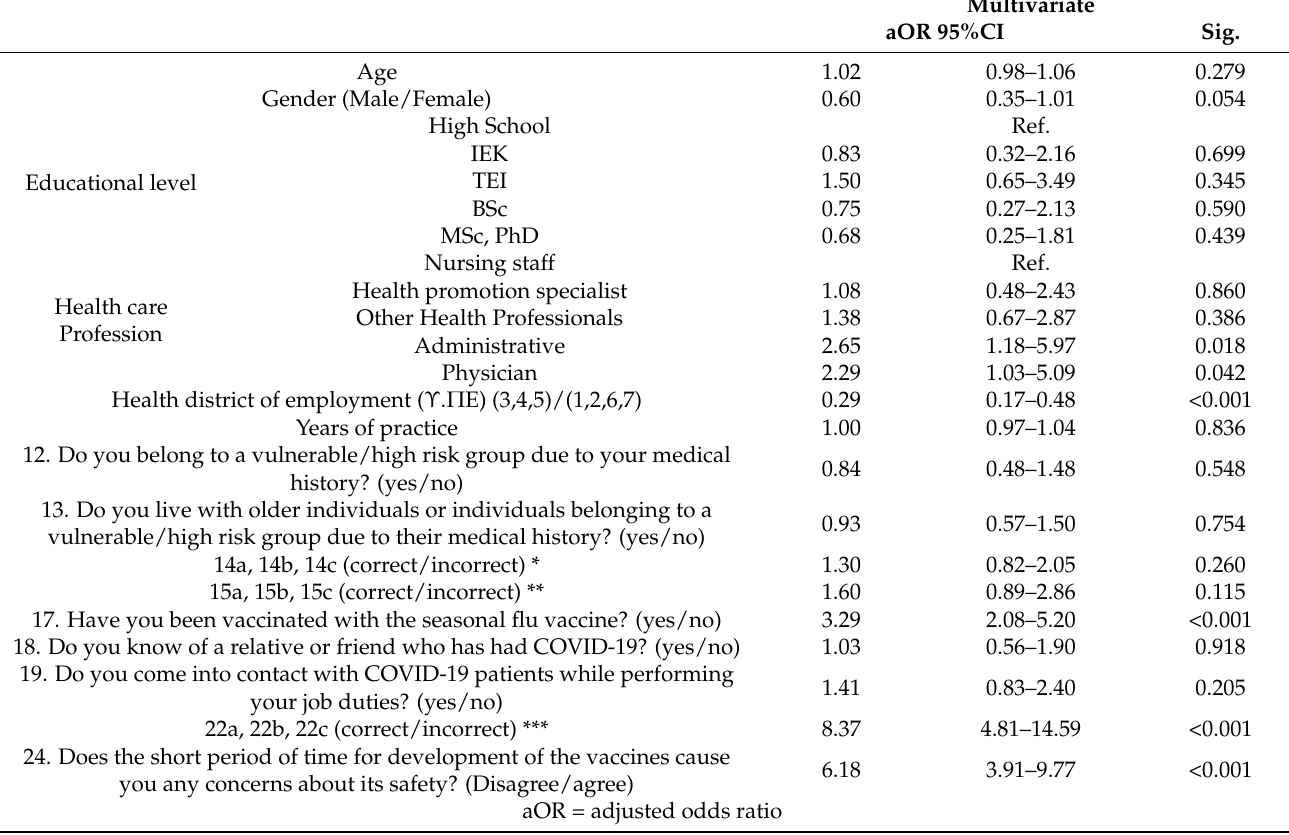
Table 4. Factors associated with COVID-19 vaccine acceptance, expressed with adjusted odds ratio (aOR), in a multivariable